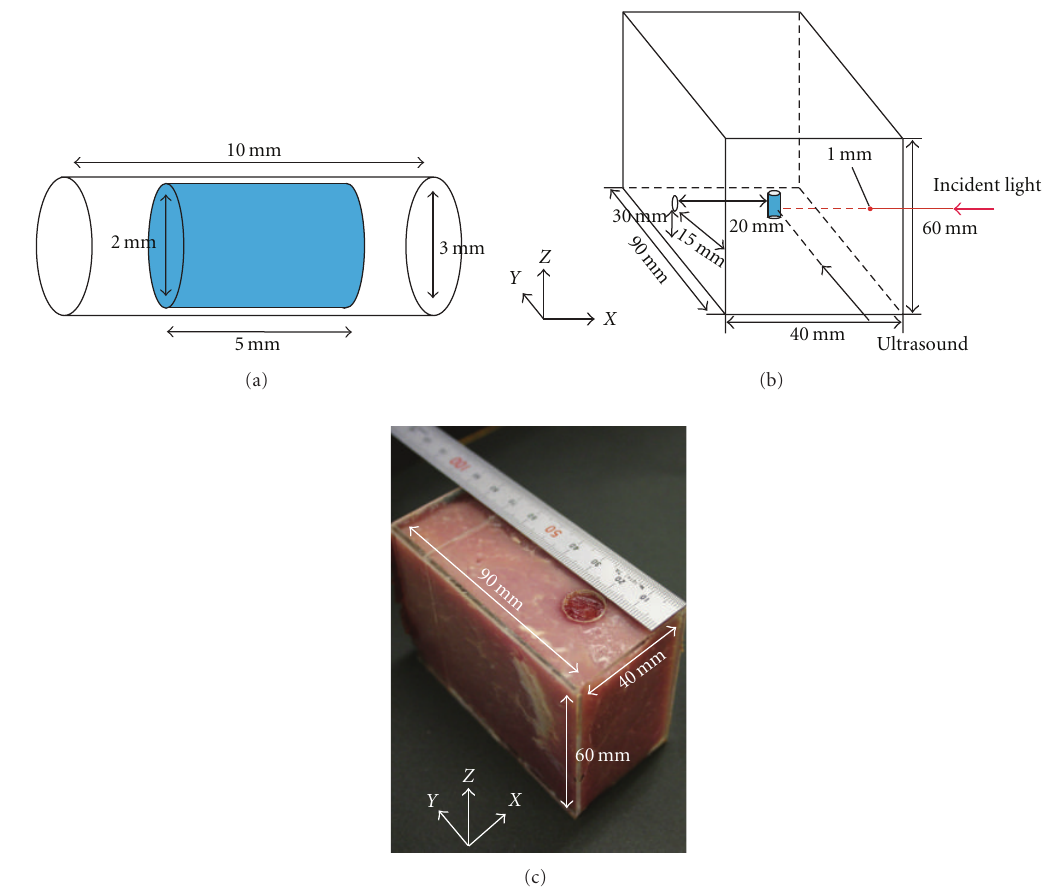
Figure 3: (a) Illustration of the fluorescent object. The fluorescent region was molded in a cylindrical silicone tube. Both heads of it were sealed with silicone gel. (b) Schematic of the tissue sample showing the buried position of the fluorescent object. Incident direction of excitation light beam and ultrasonic beam are indicated. (c) Appearance of the sample in an acrylic plastic